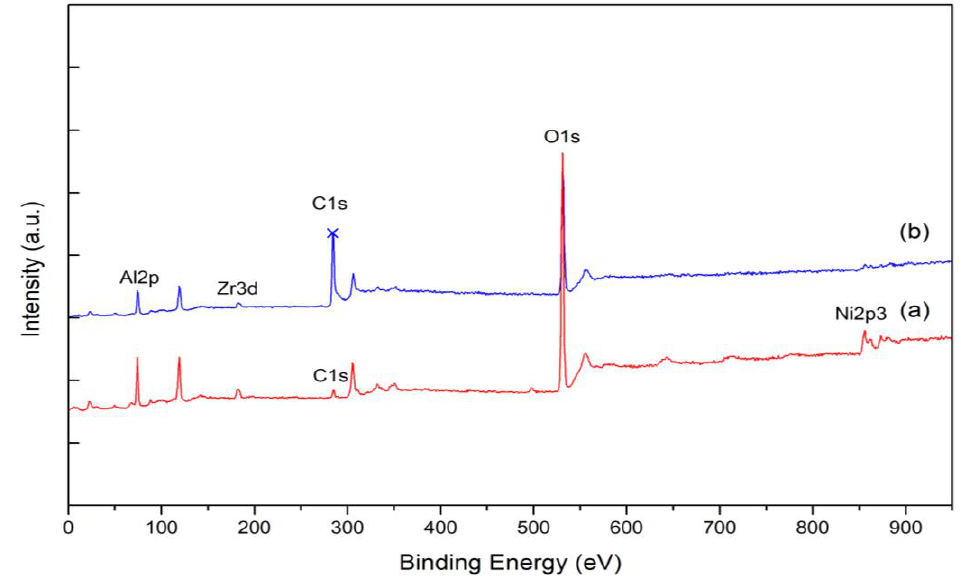
Figure 5. XPS patterns of the ( a ) Fresh and ( b ) Spent 3 wt.% Ni/Ce-Mg-Zr/Al 2 O 3 catalyst.